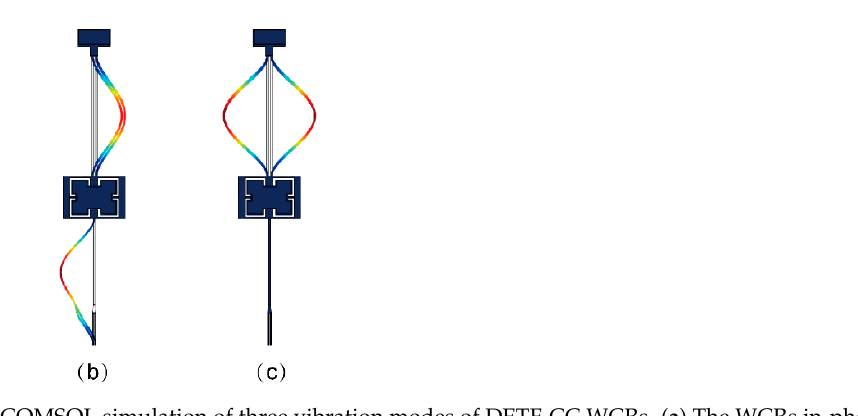
Figure 5. COMSOL simulation of three vibration modes of DETF-CC WCRs. ( a ) The WCRs in-phase mode; ( b ) the WCRs out-of-phase mode; ( c ) the DETF out-of-phase mode. The corresponding frequency shifts of the three modes in DETF-CC WCRs with ac- celeration variations from − 1 g to +1 g at 330 K temperature are shown in Figure 6a. The frequency shift of the DETF out-of-phase mode is 10 Hz (24 ppm/g), as shown in the